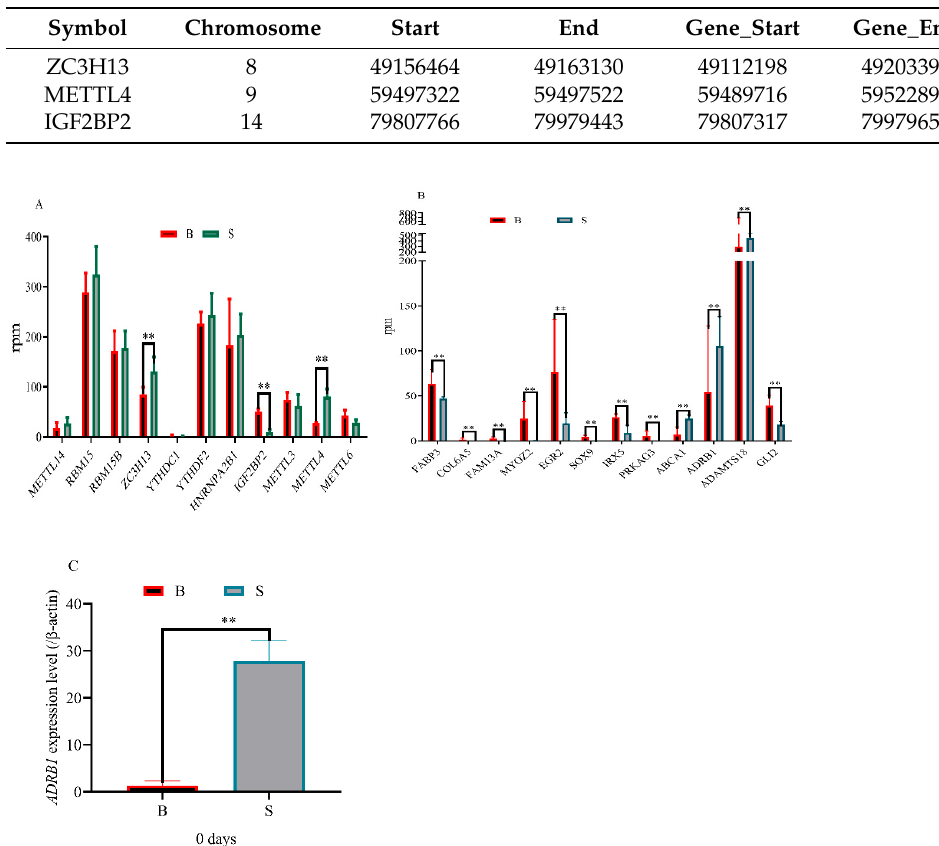
Table 3. Summary of methylase genes between muscle and fat tissues.